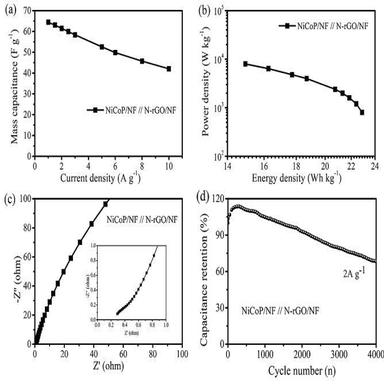
(a) The specific capacitance vs. current densities, (b) Ragone plot, (c) Nyquist plot of the device, (d) Cycle performance.